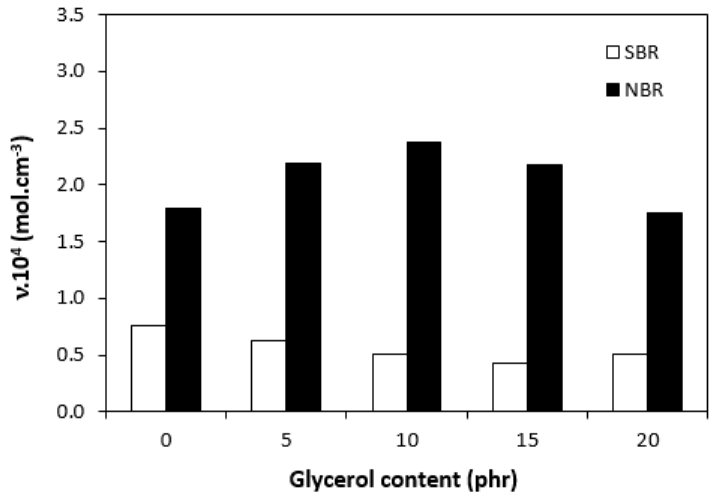
Figure 6. Influence of glycerol content on cross-link density ( υ ) of vulcanizates.